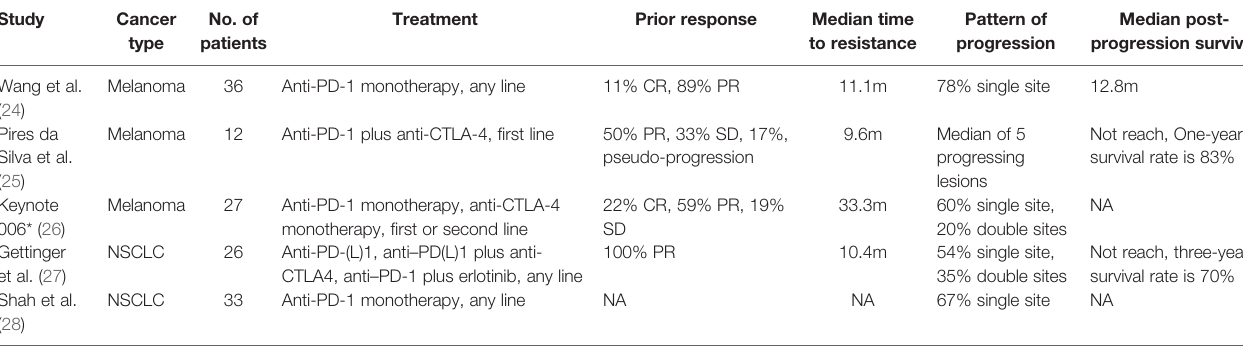
TABLE 2 | Clinical characteristics of acquired resistance to